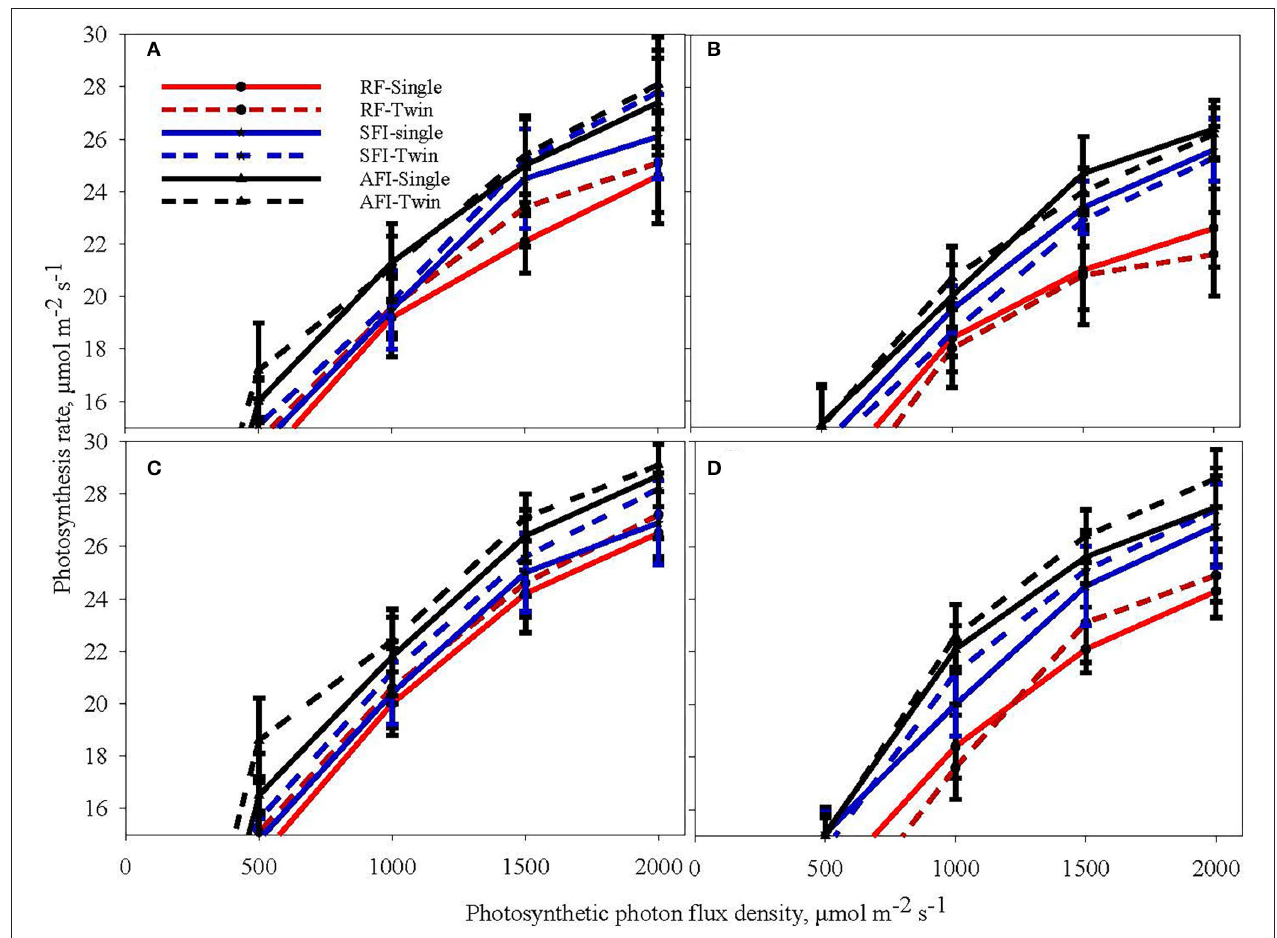
FIGURE 2 | Light response curves of soybean at the sixth leaf (V6) stage (A,B) and beginning seed set (R5) stage (C,D) during the crop growing seasons in 2018 (A,C) and 2019 (B,D) at different levels of irrigation (AFI- all furrow irrigation SFI- skipped furrow irrigation and RF-rainfed) and planting geometries (SR-single row and TR-twin